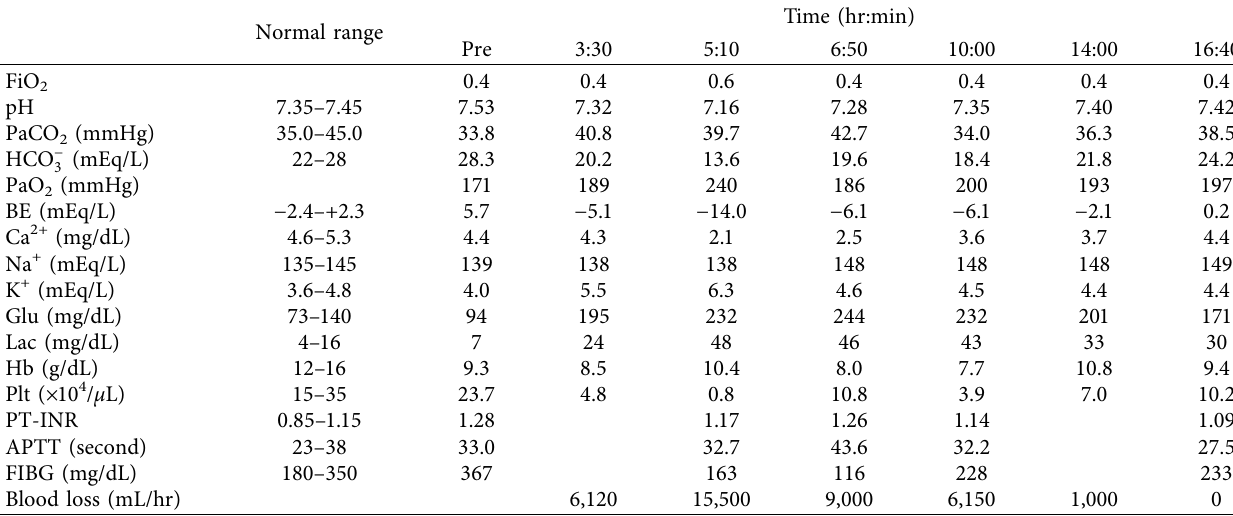
Figure 3: Changes in the electrocardiogram due to electrolyte abnormalities. Upper part: one hour after the start of surgery. Middle part: five hours after the start of surgery. Bottom part: nine hours after the start of surgery. The unit of K + is mEq/L, the unit of Ca 2+ is mg/dL, and the unit of QTc is msec. Table 1: Representative laboratory data.